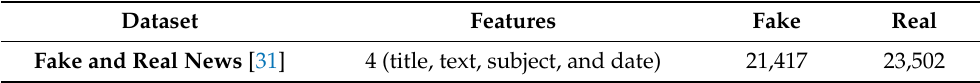
Table 1. Fake and Real News dataset details.